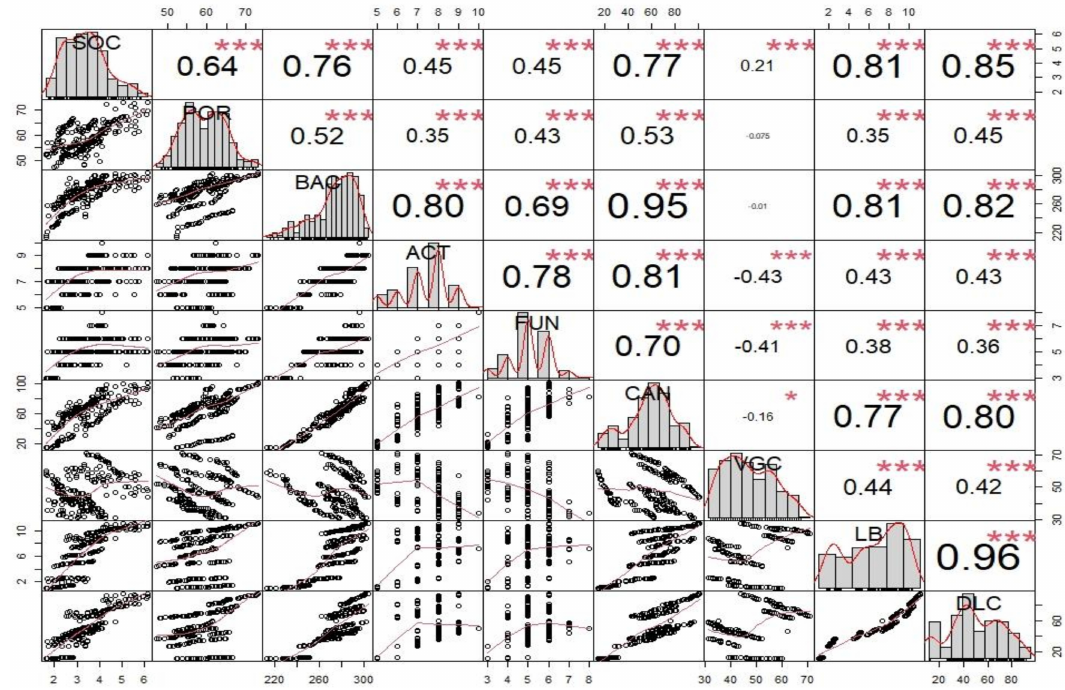
Figure 3. Correlation matrix of the measured soil health parameters (SOC: soil organic carbon (%); POR: soil porosity (%); BAC bacteria counts, ACT: actinomycetes counts, and FUN: fungi counts, in millions organisms / gram soil, respectively) and vegetation parameters (CAN: canopy cover (%); DLC: dried litter cover (%); VGC: vegetation ground cover (%); LB: litter biomass (kg / ha)); r values and * and *** indicate p < 0.05, and p < 0.001, respectively, in